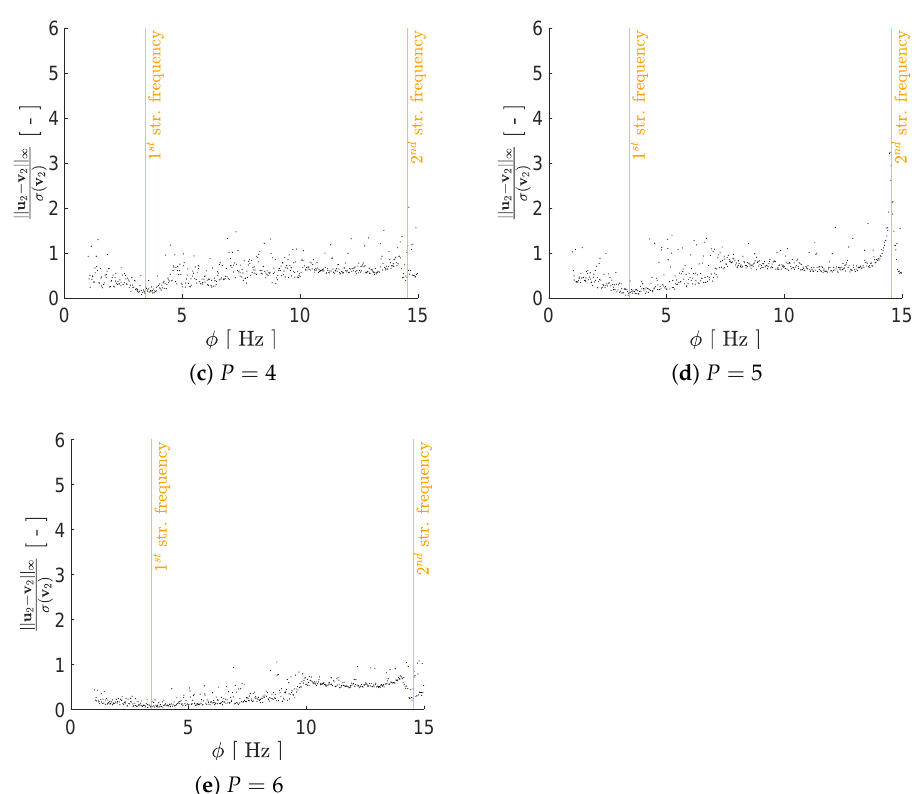
Figure 11. Two-storey shear building, configuration B. Reconstruction error for floor displacement v 2 via the standardized L ∞ norm, as a function of the load frequency φ and for a varying value of P . In the charts, the dots refer to the test set.